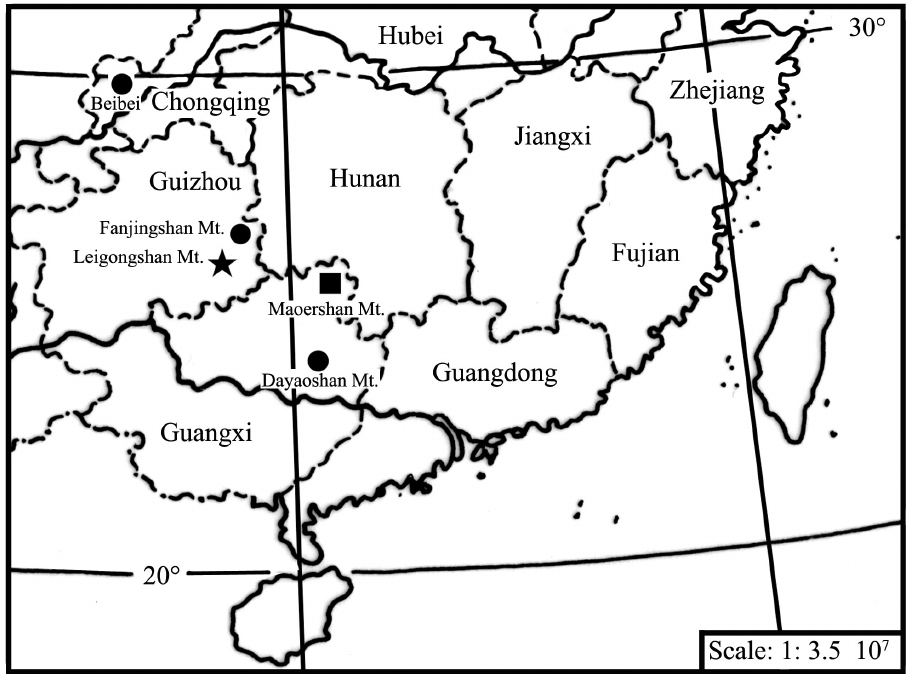
Figure 40. Geographic distribution of the species examined: T. ( V. ) bicalcarata ( ● ), T. ( V. ) leigongshanensis sp. n. (  ), T. ( V. ) maoershanensis sp. n. ( 